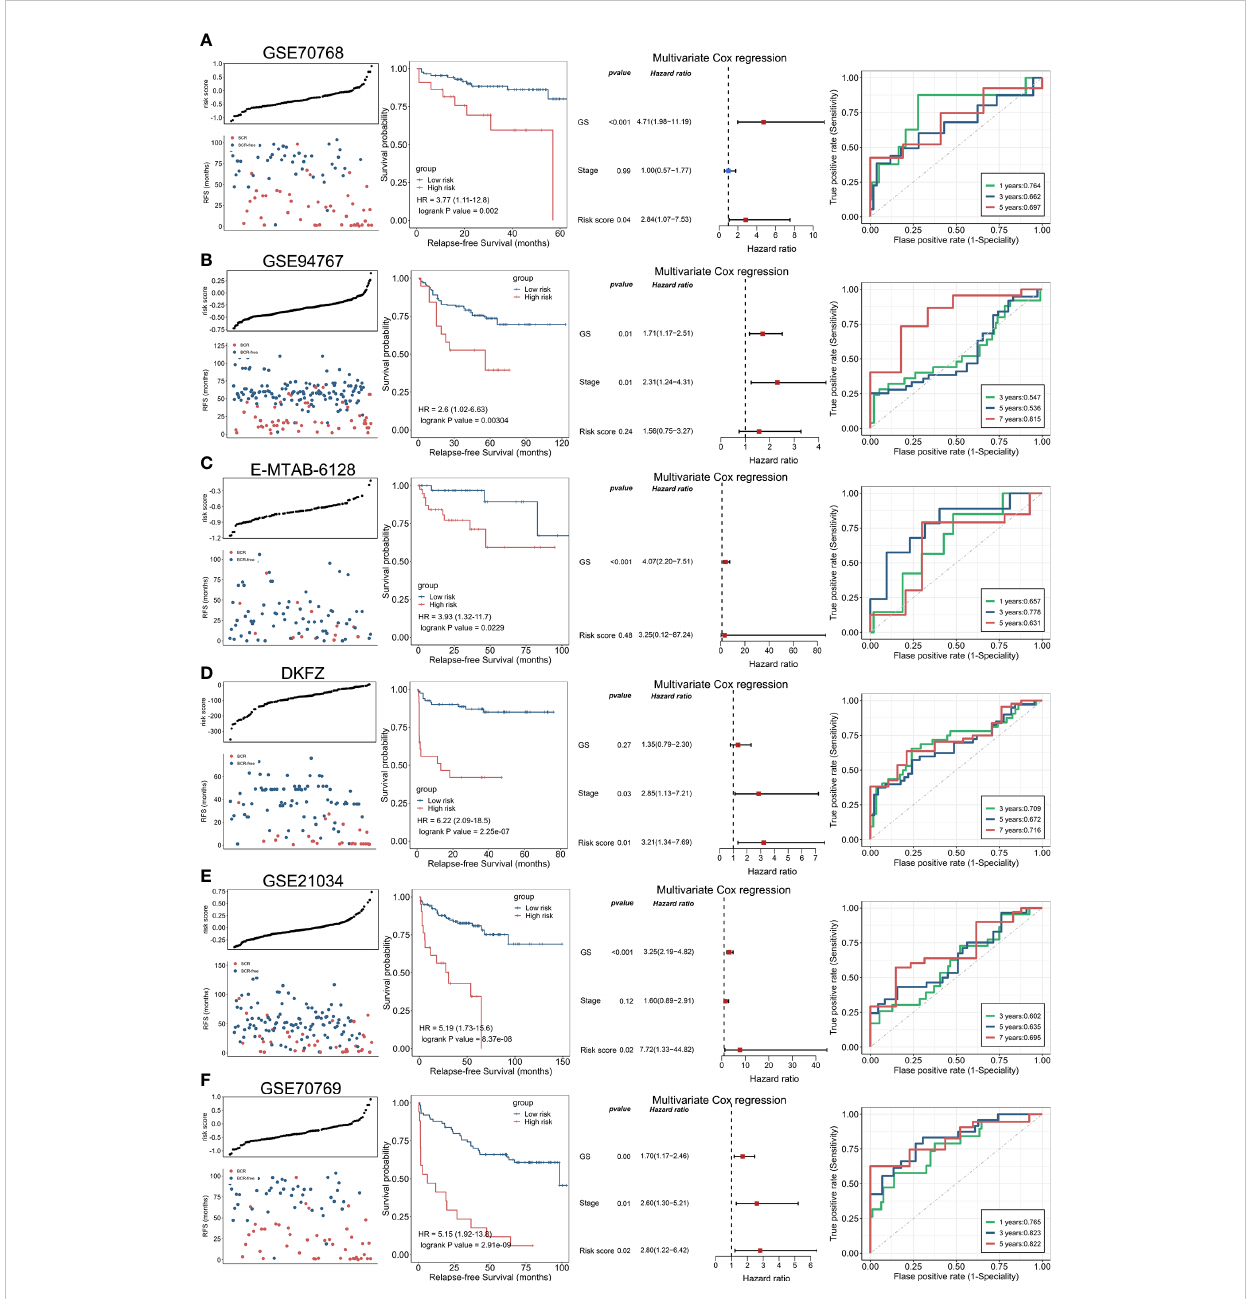
FIGURE 4 Validation of enzalutamide-induced signature in independent cohort. The plot of risk score and RFS status, Kaplan – Meier curve, multivariate Cox regression analysis, and receiver operating characteristics curve for evaluating the predicting ability of enzalutamide-induced signature in GSE70768 (A) , GSE94767 (B) , E-MTAB-6128 (C) , DFKZ (D) , GSE21034 (E) , and GSE70769 (F) cohorts,